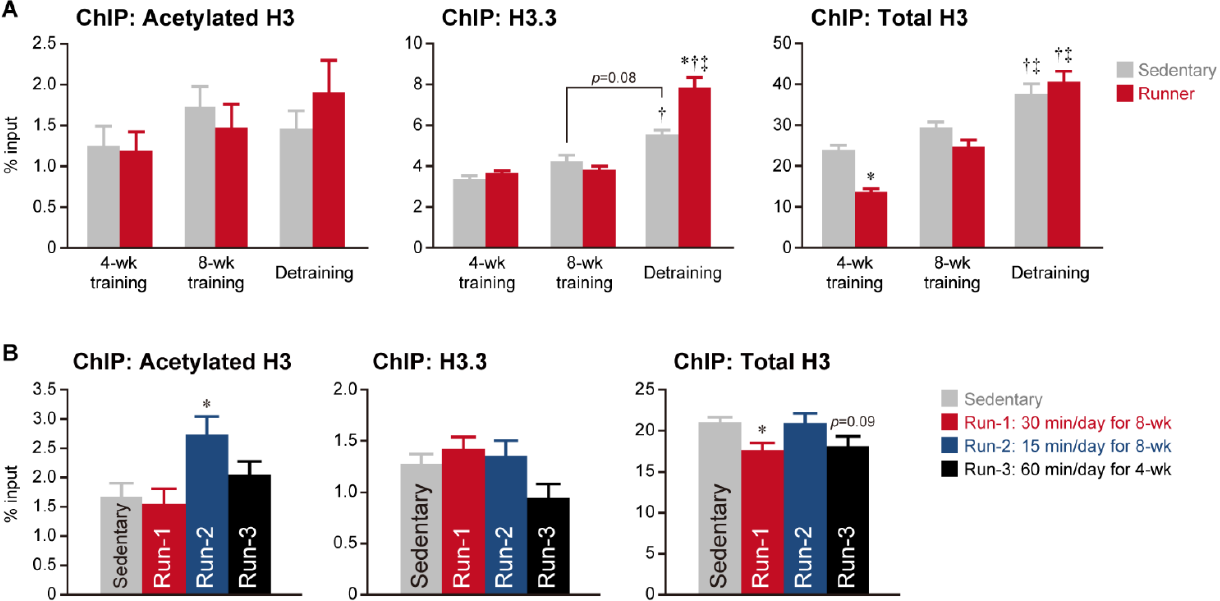
Figure 3. Changes in histone modifications after exercise training in rat plantaris muscle. ( A ) Distribution of histone modifications analyzed by ChIP-qPCR. Running training was performed using a treadmill (40 min/day) for 8 weeks followed by 8 weeks of detraining. The genes that were upregulated in response to muscular inactivation by tail suspension were targeted for the analysis. The data were obtained from Nakamura et al. [25] and re-analyzed for the statistics. Significant difference was tested by one-way ANOVA followed by Tukey’s post hoc test. ( B ) Distribution of histone modifications analyzed by ChIP-qPCR after running training with different protocols. The data were obtained from Ohsawa et al. [26] and re-analyzed. The original result was represented as the relative distribution of acetylated H3 or H3.3 to the level of total H3. Since the alteration in total H3 distribution is also an important parameter, the data were separately shown in this review. *, †, and ‡: p < 0.05 vs. sedentary, and 4 wk- and 8 wk-trained group,